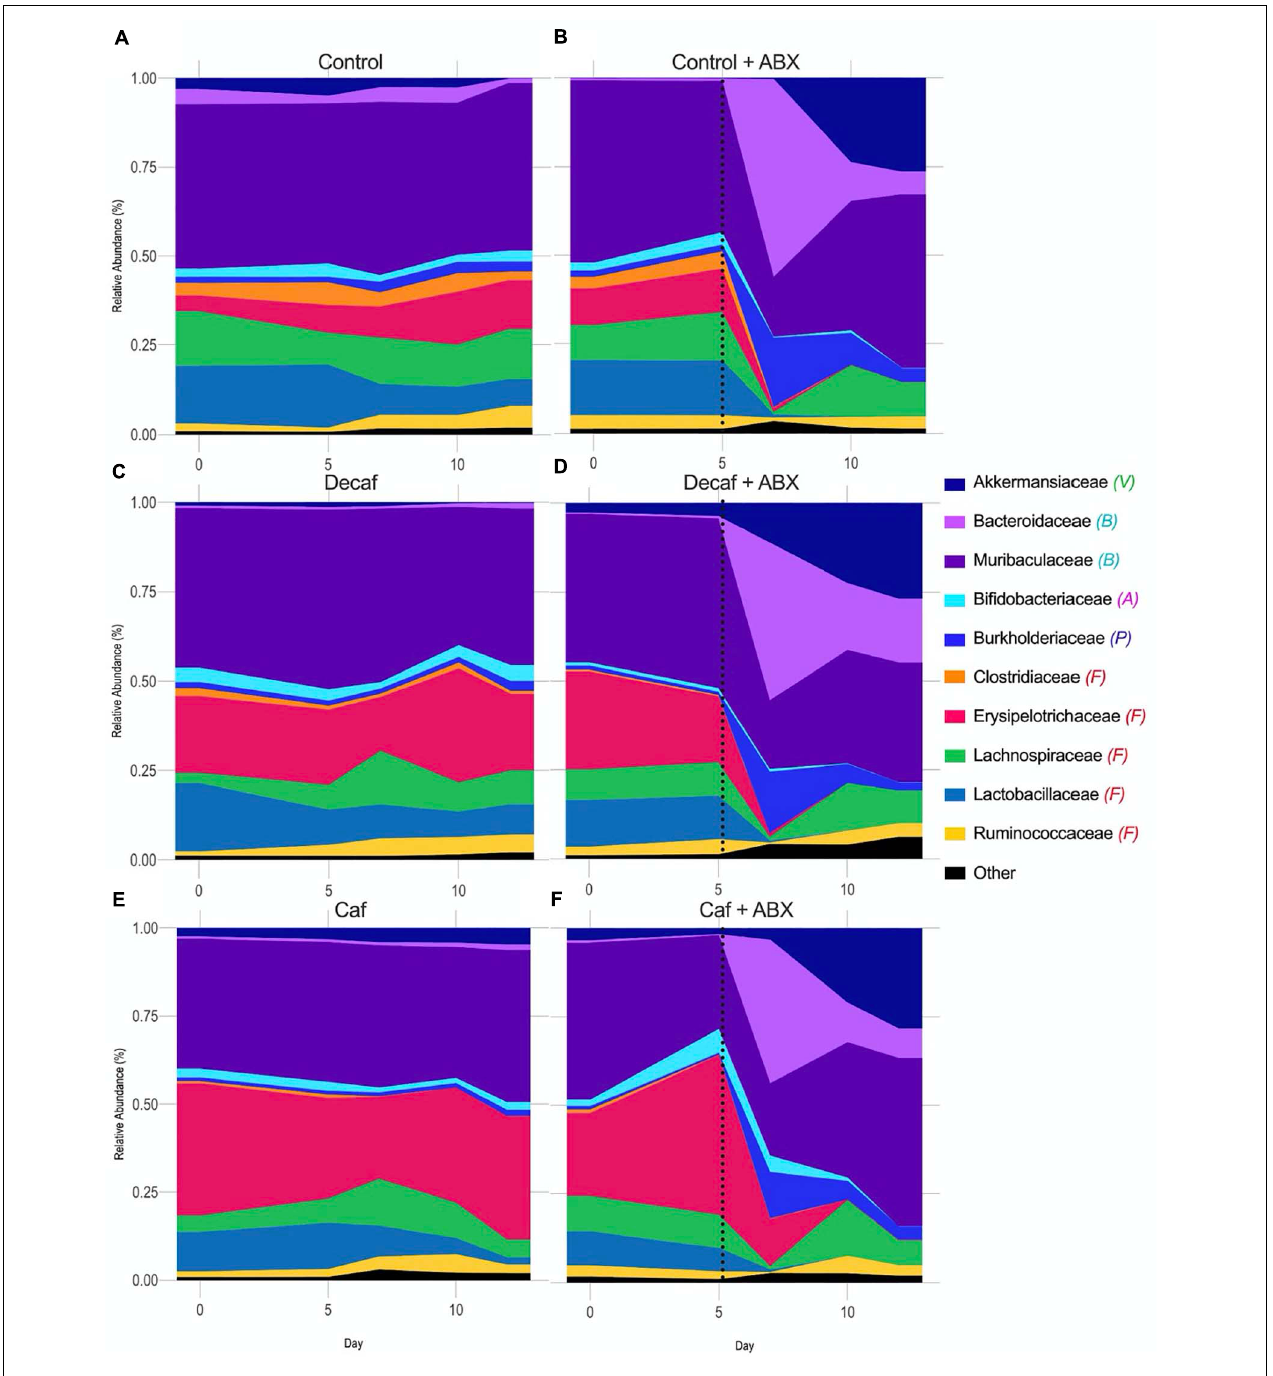
FIGURE 3 | Relative abundance of bacterial families over the course of the experiment. Phylum denoted by: V, Verrucomicrobia; B, Bacteroidetes; A, Actinobacteria; P, Proteobacteria; F, Firmicutes. Dotted line denotes beginning of antibiotic treatment. (A) Control, (B) Control + amoxicillin days 5–12, (C) Decaf, (D) Decaf + amoxicillin days 5–12, (E) Caf, (F) Caf + amoxicillin days 5–12; n =